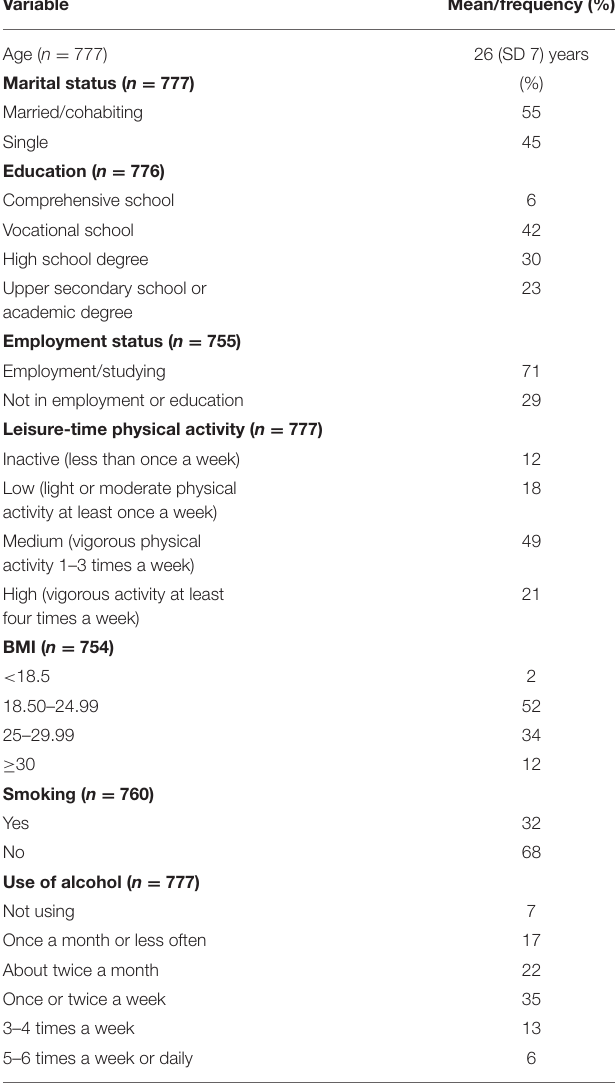
TABLE 1 | Characteristics of the study